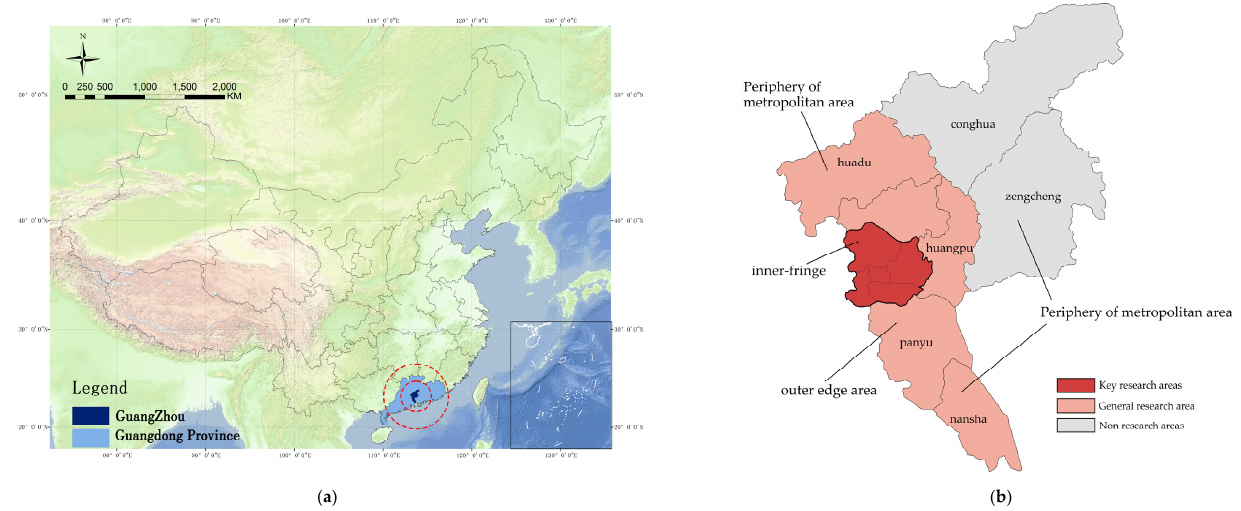
Figure 1. Guangzhou city: ( a ) the location of Guangzhou in China; ( b ) the study area. Guangzhou spans eleven districts, covering a combined area of 7434 km 2 . The